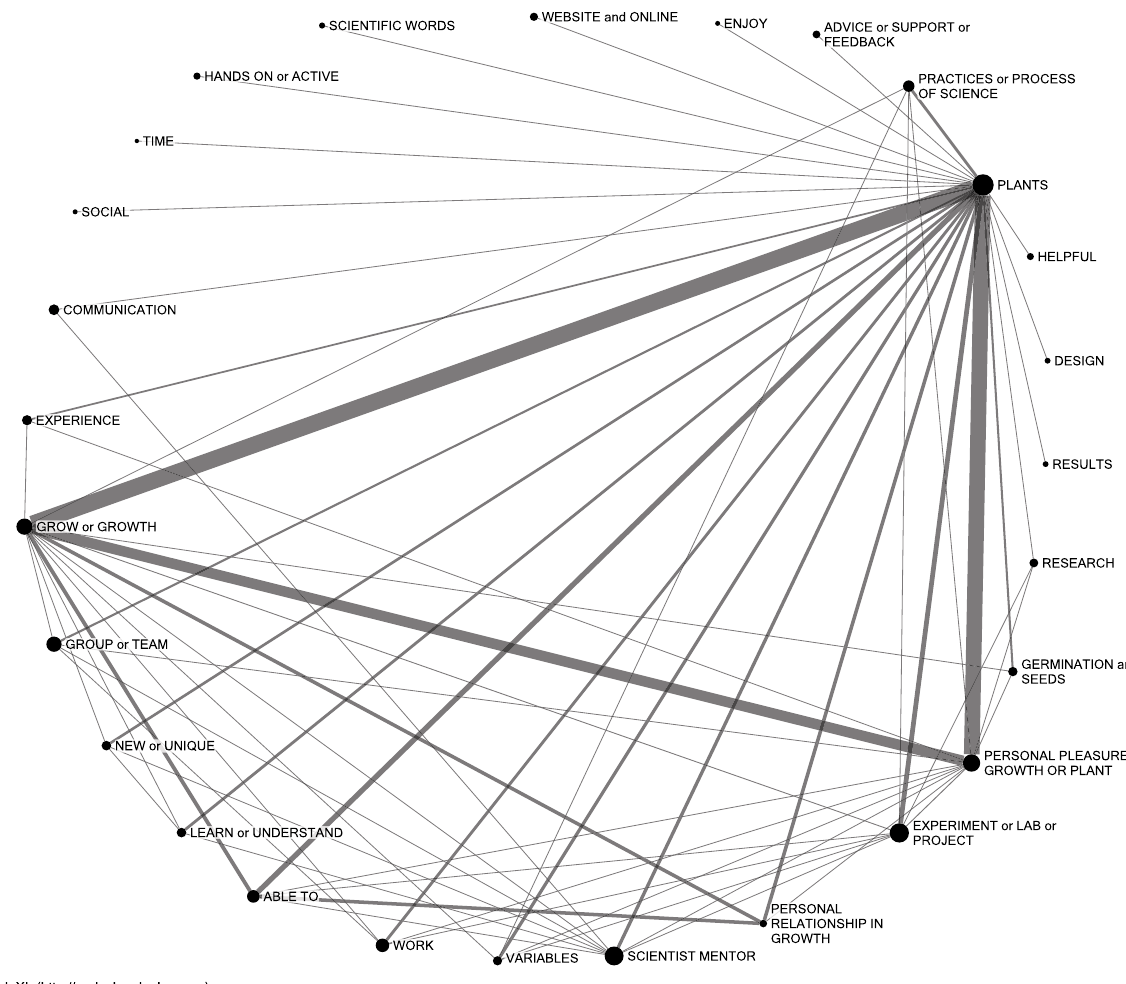
Figure 2. Lexical web illustrating connections of students’ comments about liking the plants to other favored elements. The size of the node represents the number of total respondents liking that element, and the width of the line between nodes is weighted by the number of shared responses. Items with fewer than 10 respondents are filtered out to simplify the lexical